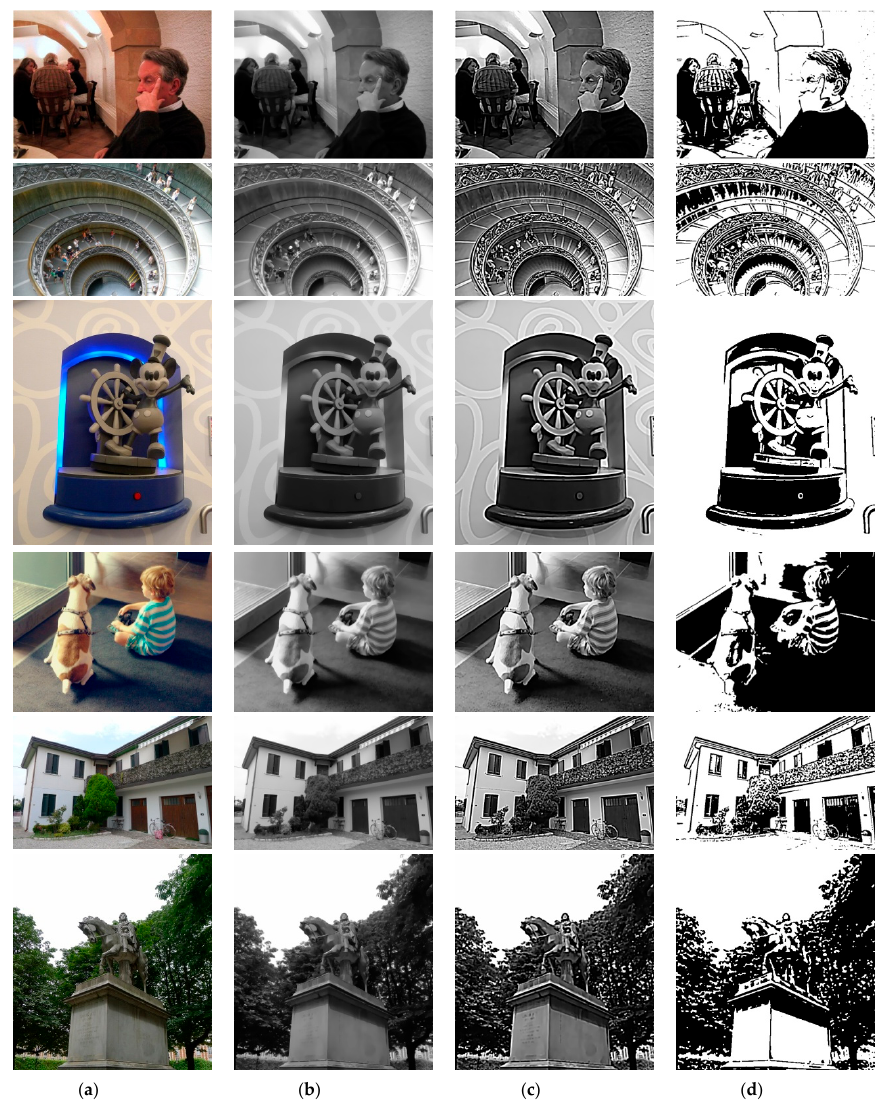
J. Imaging 2017 , 3 , 16